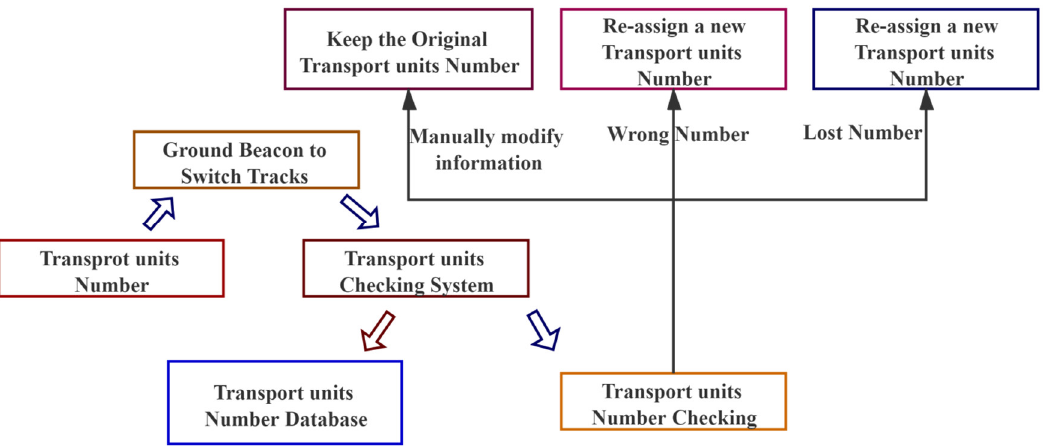
Figure 6. The Number Recognition and Repair Function.